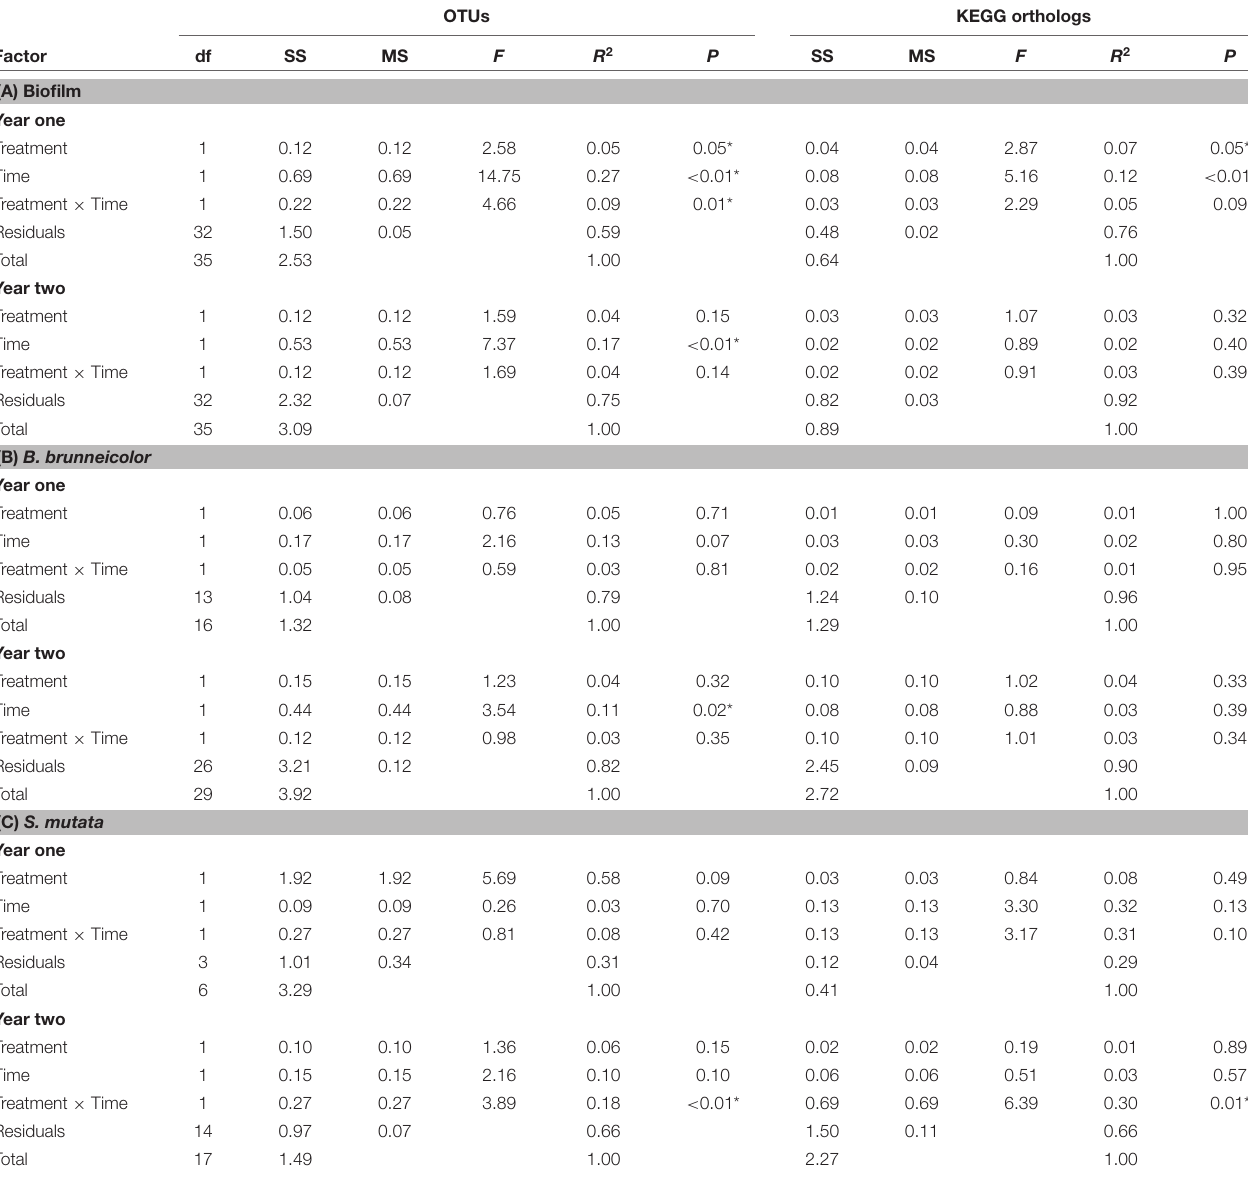
TABLE 2 | PERMANOVA results testing microbial community structure based on the weighted phylogenetic distance (UniFrac) matrix for β -diversity and Jaccard distance matrix for KEGG orthologs among the microbial communities from the 2 years’ biofilms (A) , internal B. brunneicolor (B) , and internal S. mutata (C) , with significant results ( p < 0.05) indicated by an